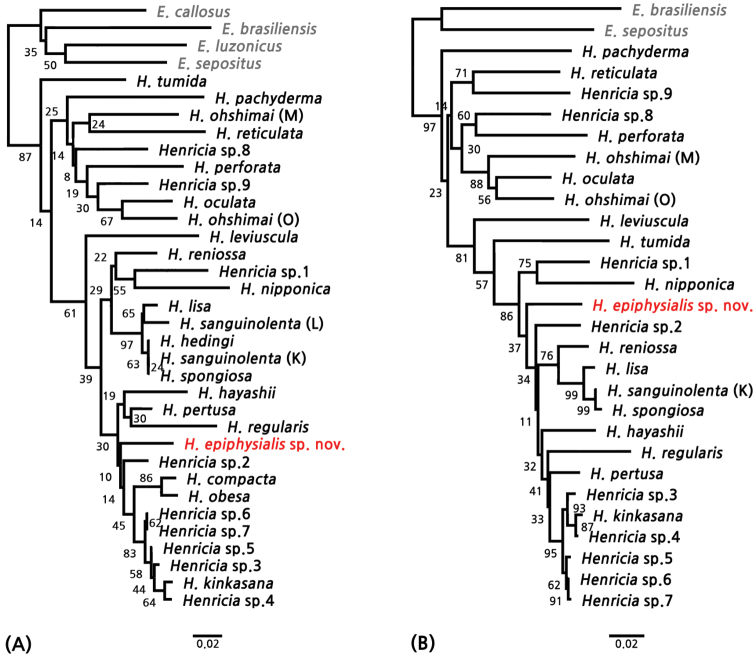
Phylogenetic trees of Henricia species including Henricia
epiphysialis sp. nov. based on Neighbor joining (NJ) ANJ tree constructed with 189 bp of COX1 dataset BNJ tree constructed with 537 bp of COX1 dataset; K, Knott et al., 2018; L, Lopes et al., 2016; M, Misaki, Kanagawa in Wakita et al., 2019; O, Oshoro, Hokakido in Wakita et al., 2019.